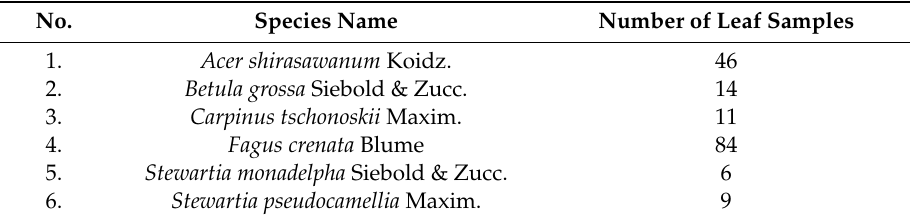
Table 1. List of species used in this